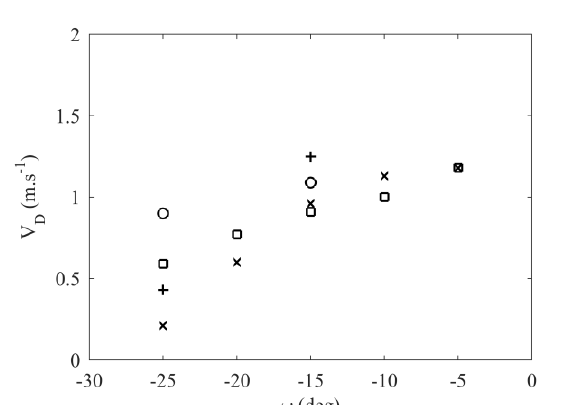
Fig. 6. Distribution of granular concentration at velocity slightly above deposition limit for flow of SP090 slurry ( C vd,max = 0.26) at pipe inclination of -25 deg, V m = 0.72 m.s -1 , C vd = 0.022 . Legend: square = experiment, x = model prediction.